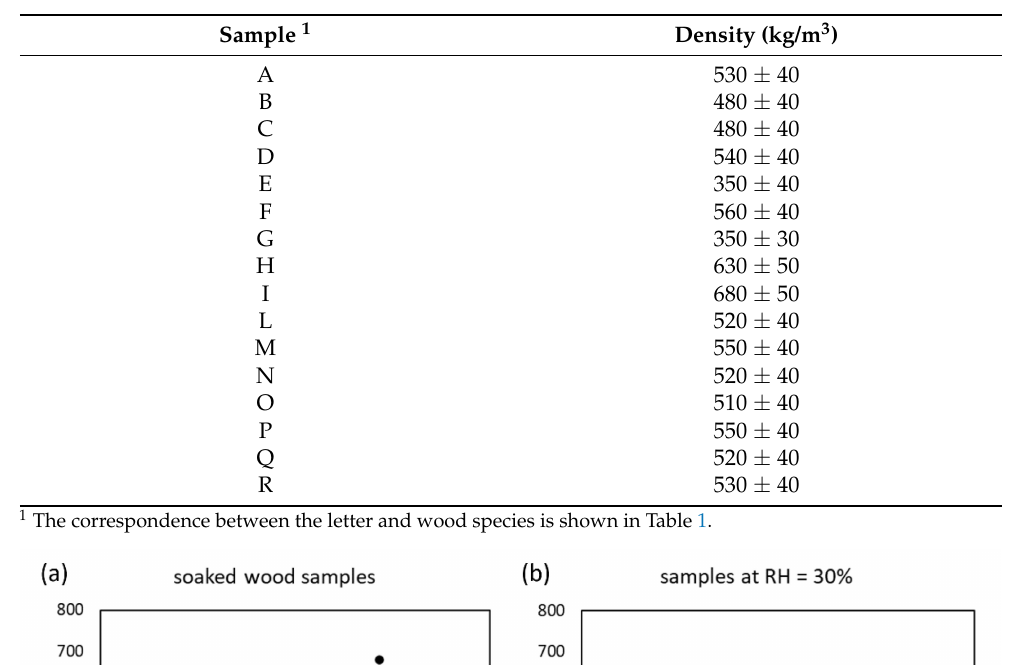
Table 6. Wood density obtained for each wood species.